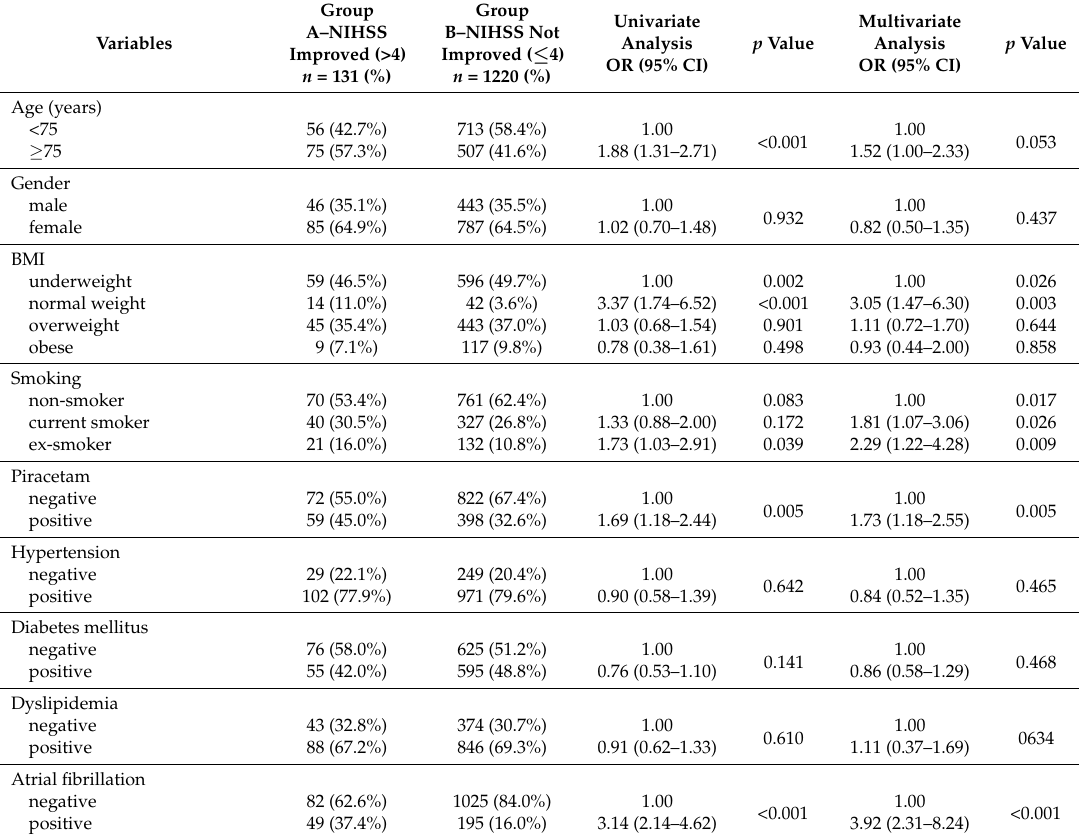
Table 2. Univariate and multivariate analyses for the associations of piracetam treatment as well as epidemiological and comorbidity factors with changes of NIHSS score in ischemic stroke patients in